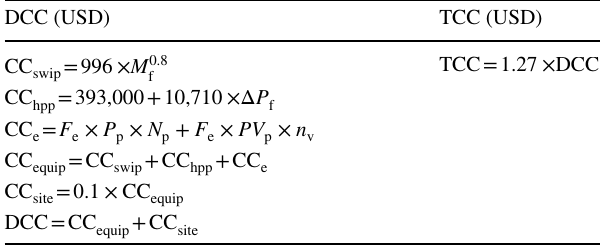
Table 8 Costs related to the RO process Table 9